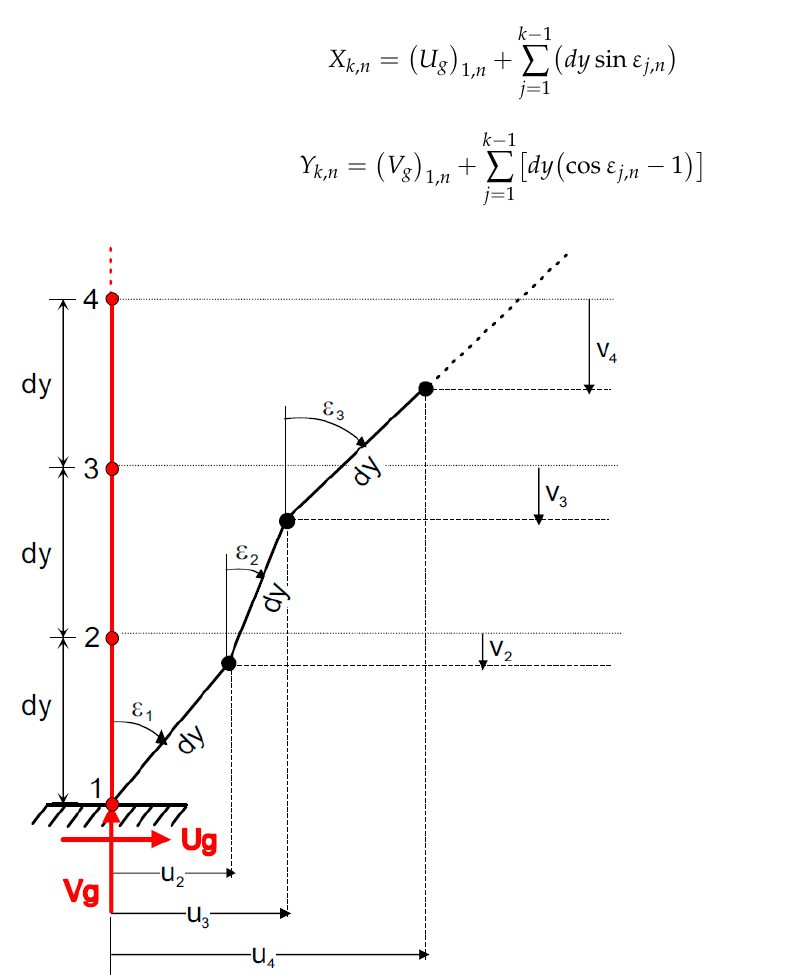
Figure 11. Horizontal and vertical displacements and rotations of the model.